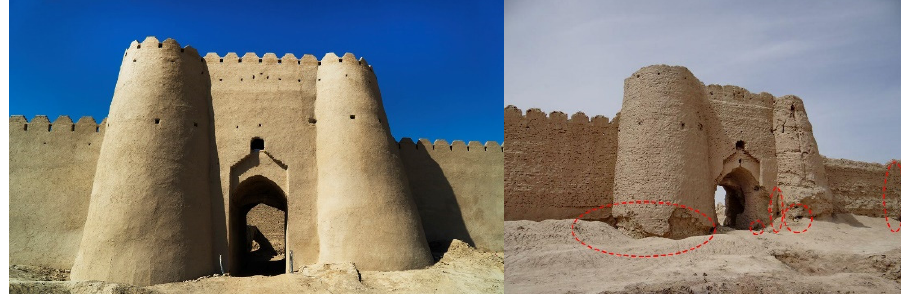
Figure 4. Rostam entrance portal (before and after conservation).